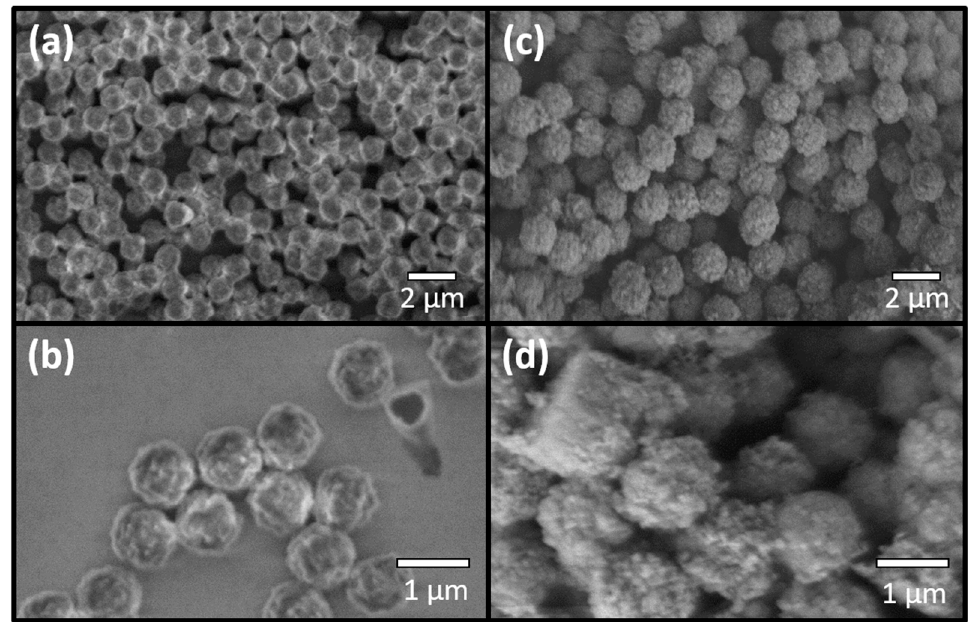
Figure 2. Images of the beads generated by SEM before the conjugation with antibodies ( a , b ) and after the conjugation ( c , d ).